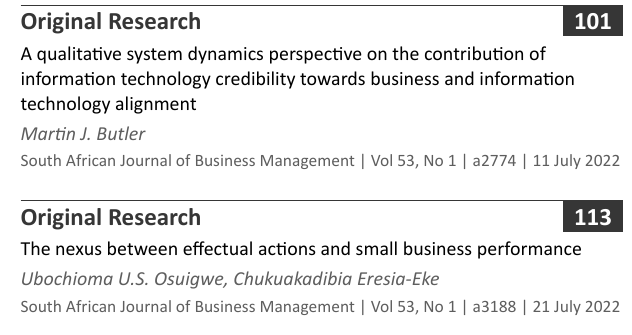
Original Research